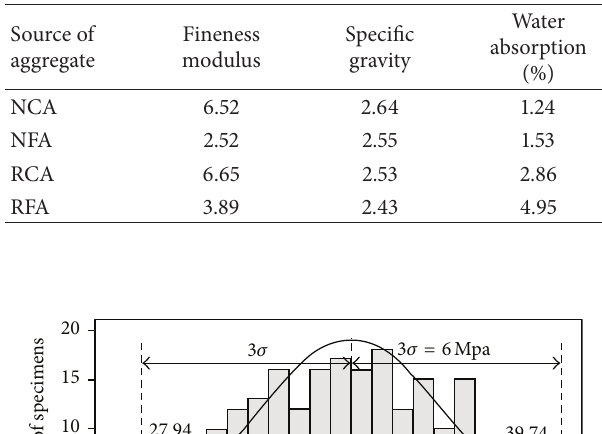
Table 1: Physical properties of RAs (1st class) and NAs.